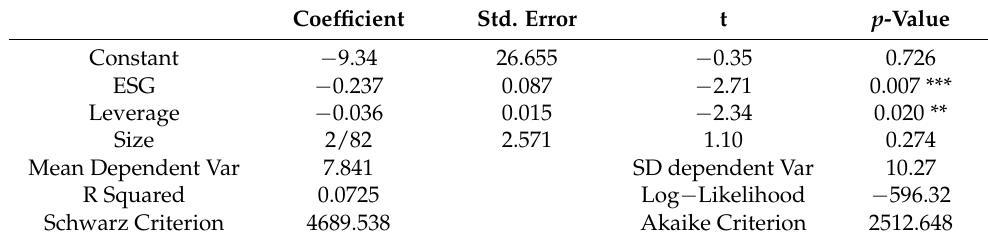
Table 8. Fixed Effects (GLS), Dependent Variable: